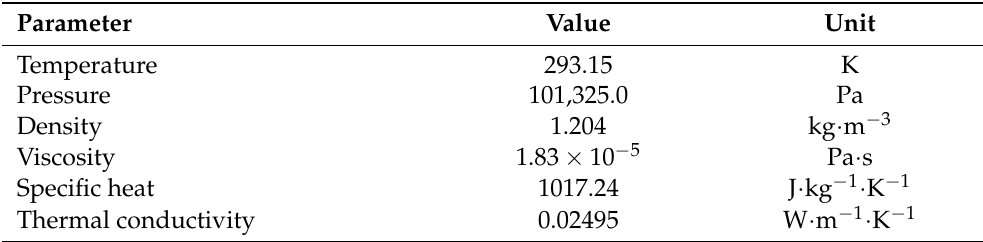
Table 2. Air properties used in the Code_Saturne